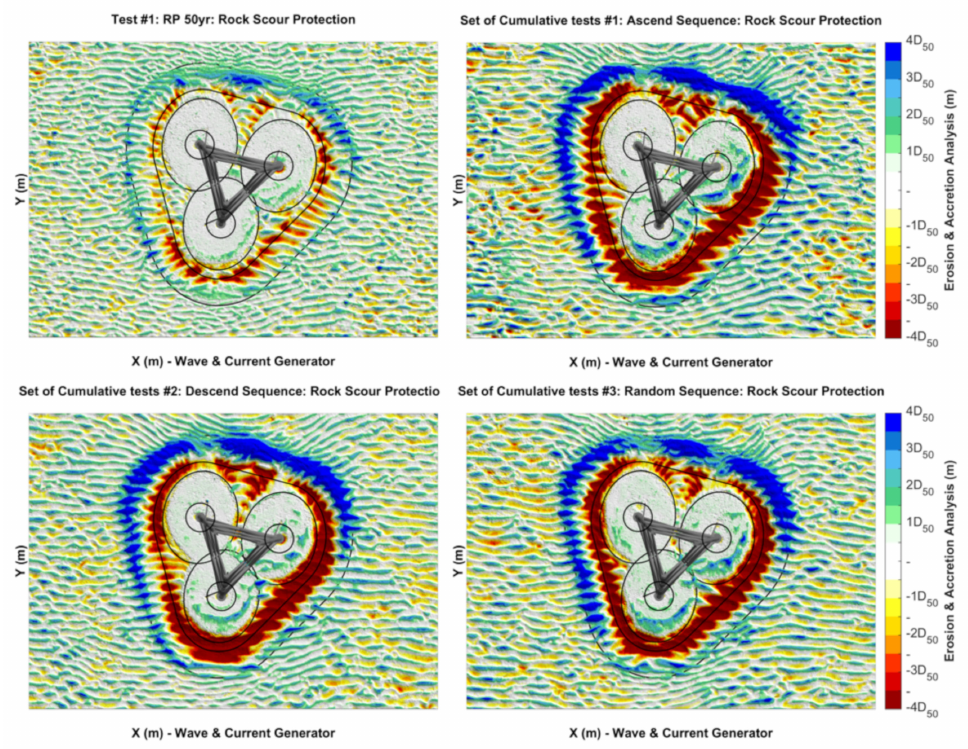
Figure 9. General view of laser scanner measurements: top left : individual, top right : cumulative ascending, bottom left : cumulative descending, bottom right : cumulative